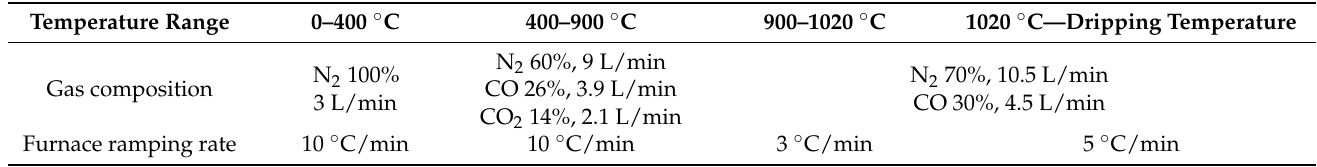
Table 5. Experimental conditions for conducting softening and melting tests.